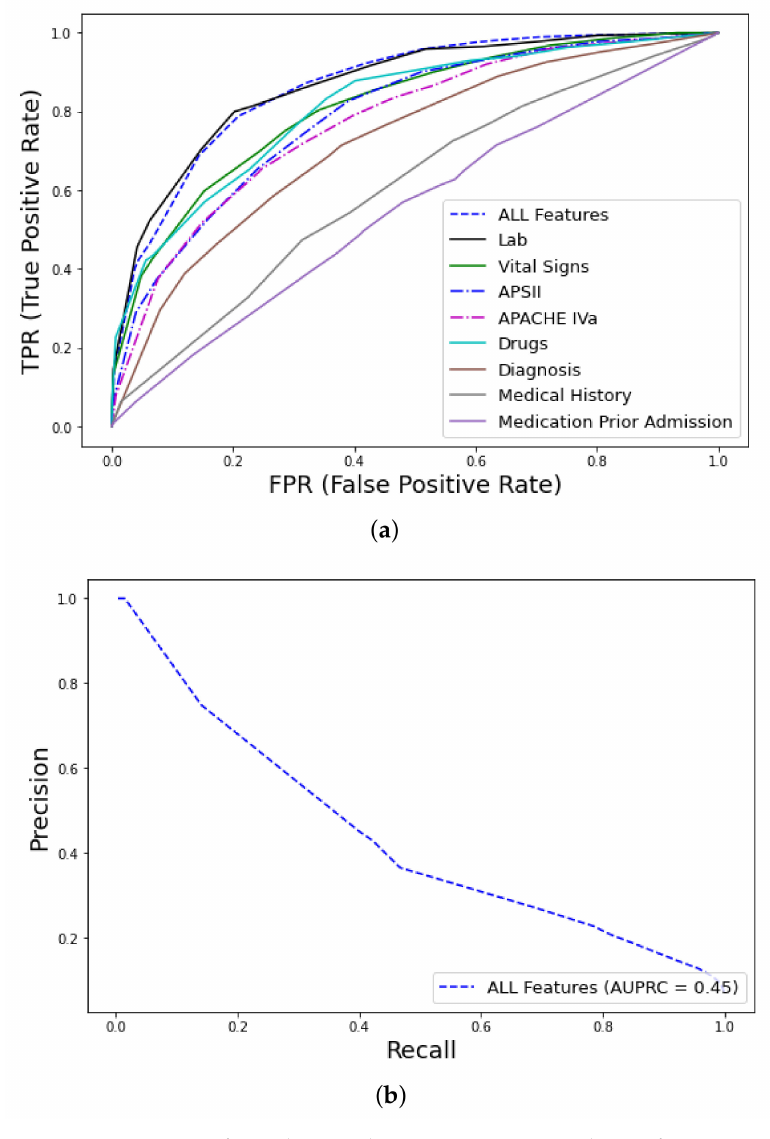
Figure 3. ROC curves for early mortality in ICU patients with VTE from eICU dataset: ( a ) AUC – ROC curves, feature discriminative analysis and comparison with clinical scores (APS, Acute Physiology Score; APACHE, Acute Physiology Age Chronic Health Evaluation), ( b ) Precision–recall curve.